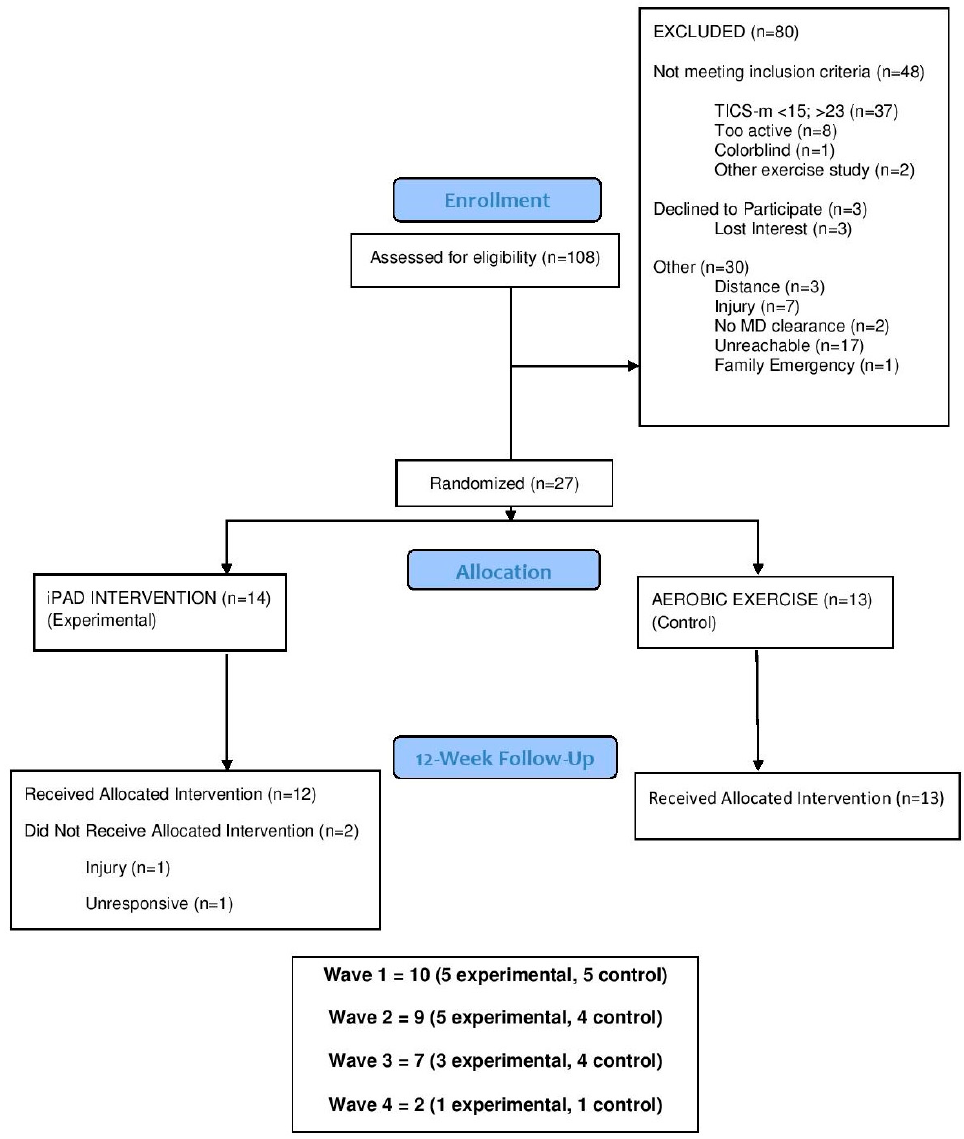
Figure 1. Flow chart of participant recruitment, randomization, and study completion.